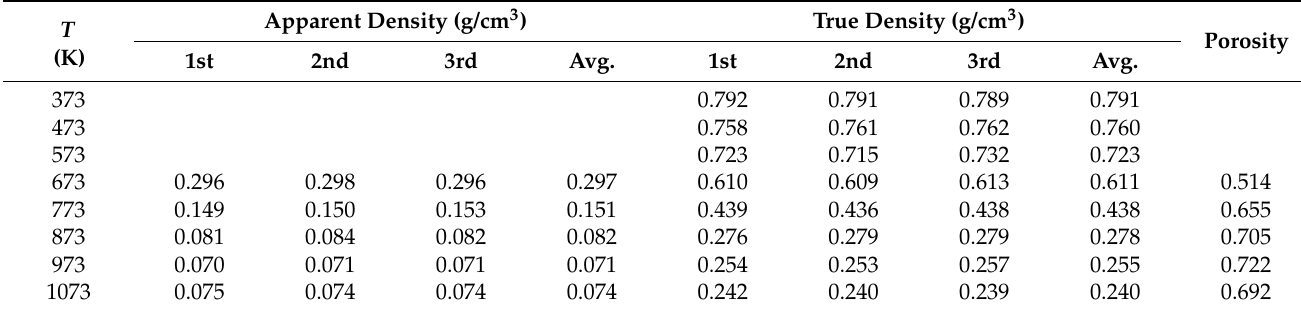
Table 2. Measured density and calculated porosity.